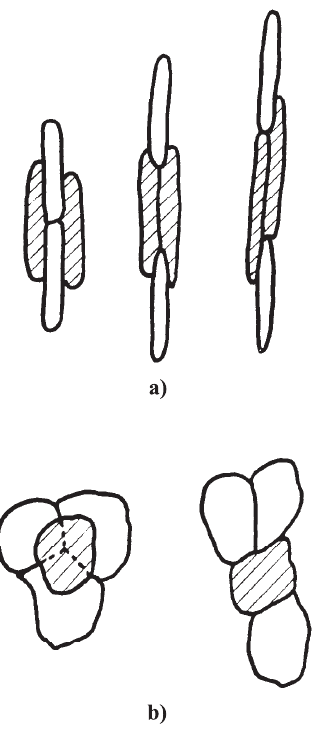
Fig. 15: Supposed reordering mechanisms: a) slip, b)